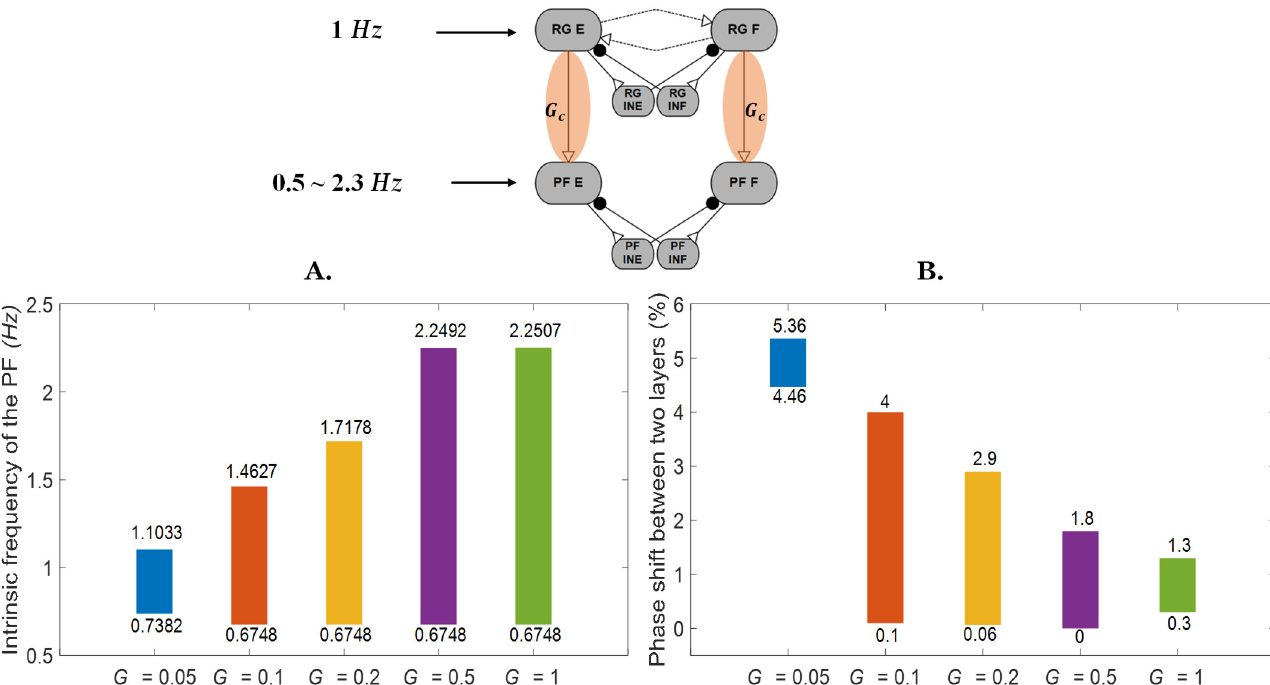
Figure 5. The rhythm generator phase locks with the pattern formation layer. ( A ) The range of pattern formation layer frequencies that phase locked to the rhythm generator is related to the connection strength of G c . (The top number reflects the maximum frequency that could phase lock, whereas the bottom number reflects the minimum frequency that could phase lock.) Outside of the ranges indicated by the bars, the two layers could not phase lock. ( B ) As connection strength increases, the range of phase differences between the pattern formation layer and rhythm generator is reduced. (The top number represents the maximum phase shift as a percentage of the normalized cycle, whereas the bottom number represents the minimum phase shift as a percentage of the normalized cycle.) However, when the connection strength is too weak ( G c = 0.05), the system is less likely to phase lock, and therefore, the range of phase differences is also reduced.